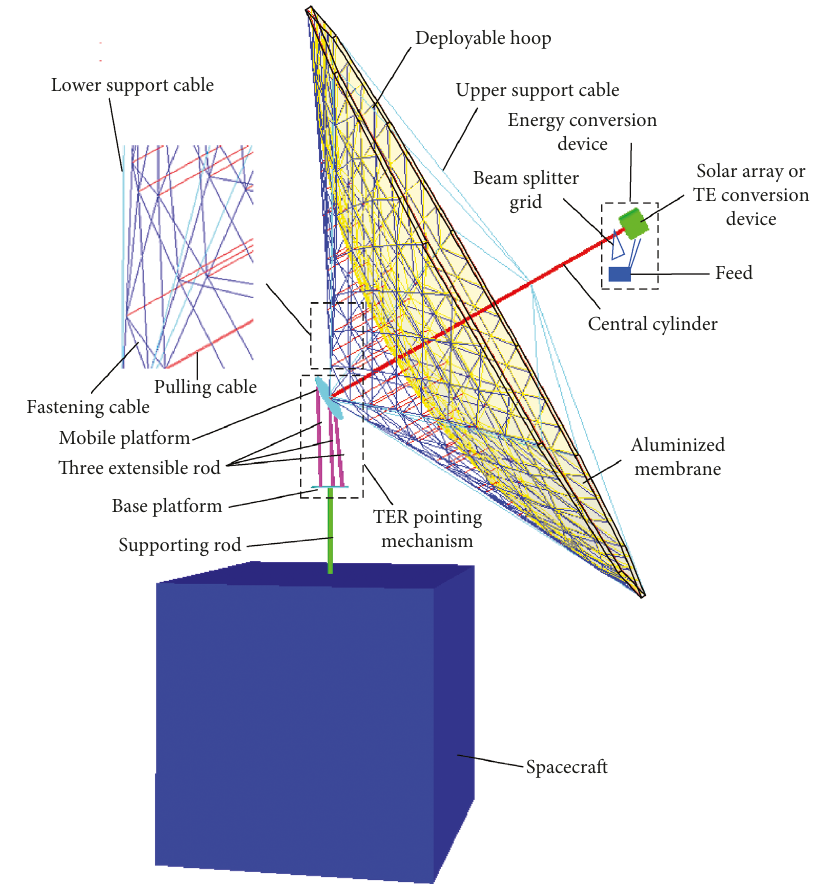
Figure 2: Overall structural design of the SSPCI.